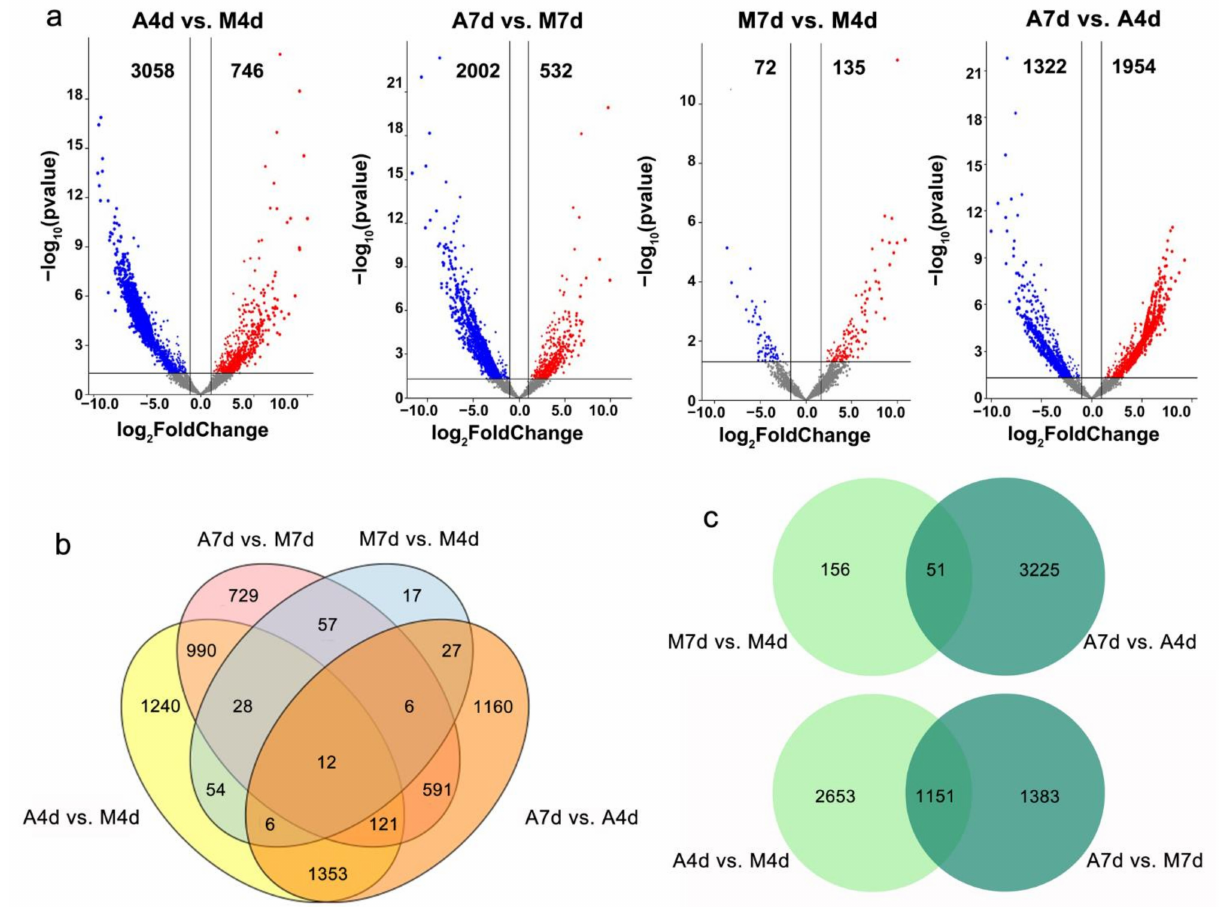
Figure 3. Different expression genes (DEGs) are induced by high alkaline stress in Dongdao-4. ( a ) Number of up-regulation and down-regulation DEGs in A4d vs. M4d, A7d vs. M7d, M7d vs. M4d and A7d vs. A4d; ( b , c ) Venn diagrams showing the overlapping of the DEGs number in response to alkaline stress among A4d vs. M4d, A7d vs. M7d, M7d vs. M4d and A7d vs.